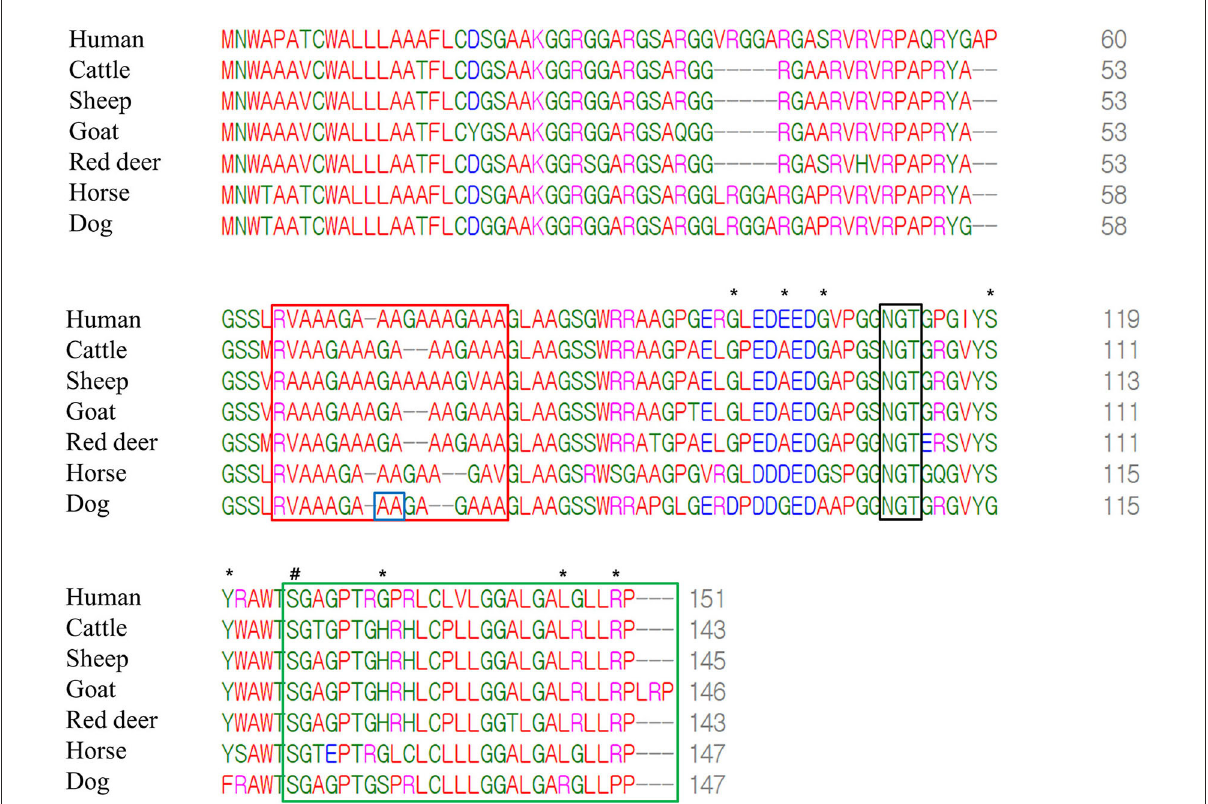
FIGURE3 Multiple sequence alignments of amino acid sequences of the shadow of prion protein (Sho) in humans, cattle, sheep, goats, red deer, horses and dogs. The colors show the chemical properties of amino acids; blue: acidic; red: small and hydrophobic; magenta: basic; green: hydroxyl, sulfhydryl, amine and glycine. Asterisks indicate dog-specific amino acids. Sharp indicates the omega site of the glycosylphosphatidylinositol (GPI) anchor. The red box indicates the interaction region of Sho with prion protein (PrP). The black box indicates the NXT glycosylation motif of Sho. The green box indicates the signal sequence of the GPI anchor of Sho. The blue box indicates genetic polymorphisms identified in the present